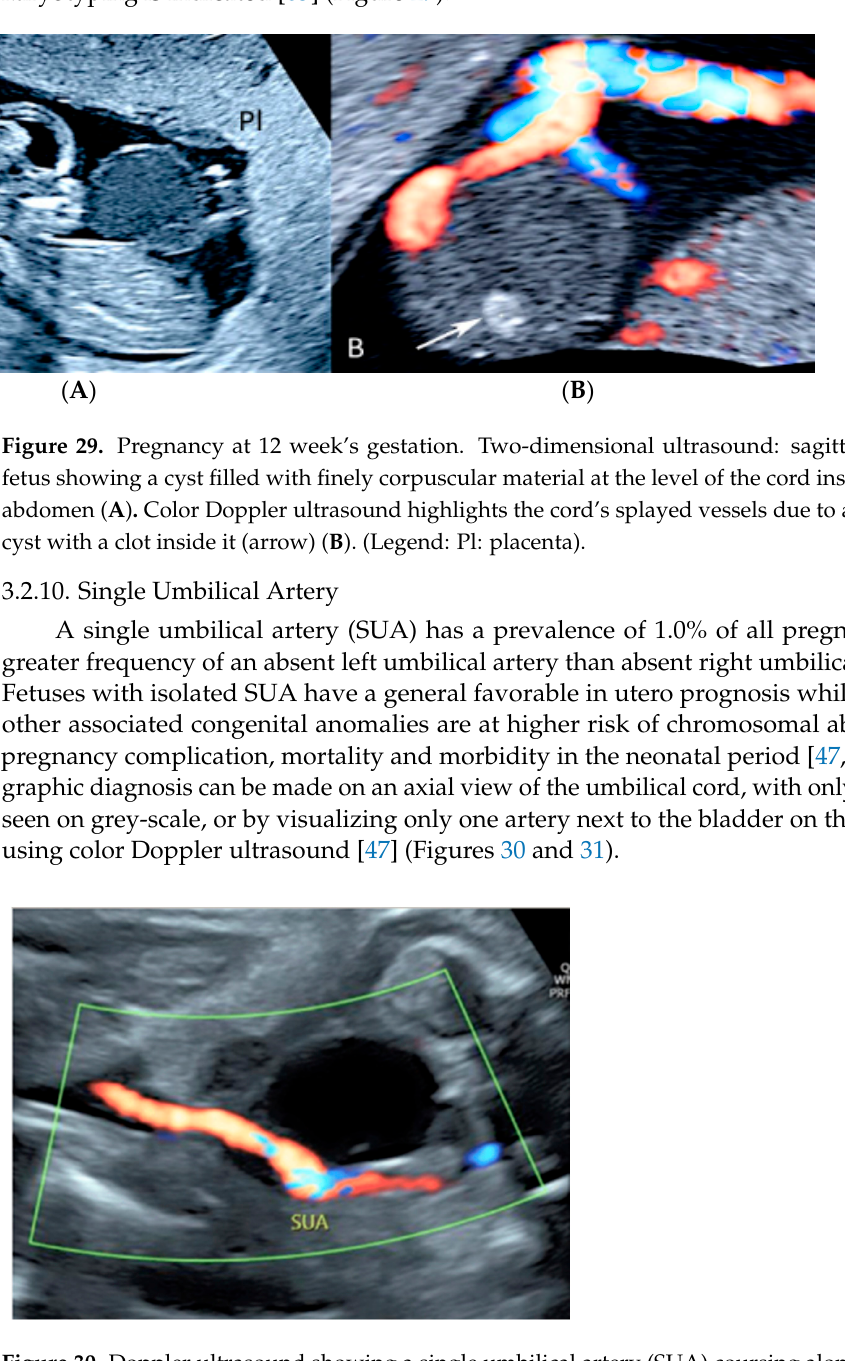
( D ) Figure 31. Pregnancy at 22 week’s gestation. Color Doppler ( A–C ) and four-dimensional STIC with color Doppler ultrasound in “glass-body” mode ( D ). Longitudinal and axial scan of the cord ( A–C ) demonstrate the presence of a single umbilical artery (SUA). SUA shows a particular paravesical kinking (Bl: bladder). 3.2.11. Umbilical Cord Varix Umbilical cord varix is a rare condition in which there is a focal dilatation larger than 9.0 mm in the intrahepatic or extrahepatic portion of the umbilical vein [47,68]. It is asso- ciated with a 5.8% risk of chromosomal aneuploidy, especially trisomy 21, and a 19% risk